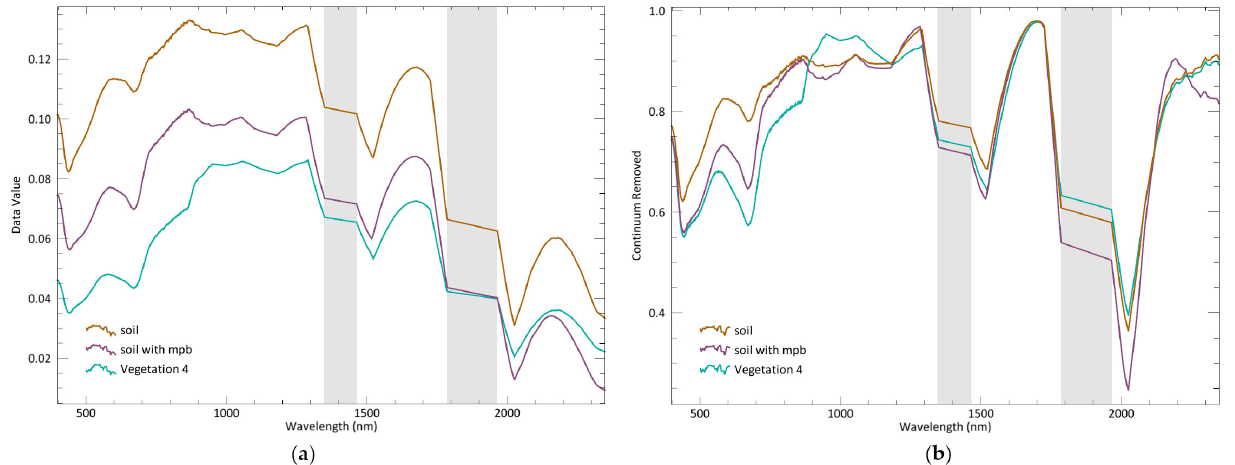
Figure 8. Comparison of the spectral responses of the S. maritimus class (vegetation 4) and soil classes: reflectance curve ( a ) and continuum removed spectra ( b ). The water vapour absorbance regions (1350–1460 nm and 1790–1960 nm) excluded from the hyperspectral processing are shown in grey.